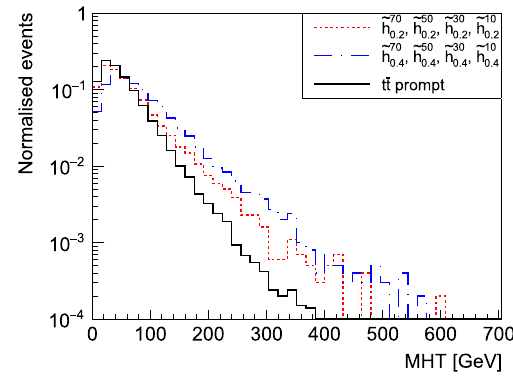
Fig. 34 Total transverse energy TET in the ˜ h 2 -like case